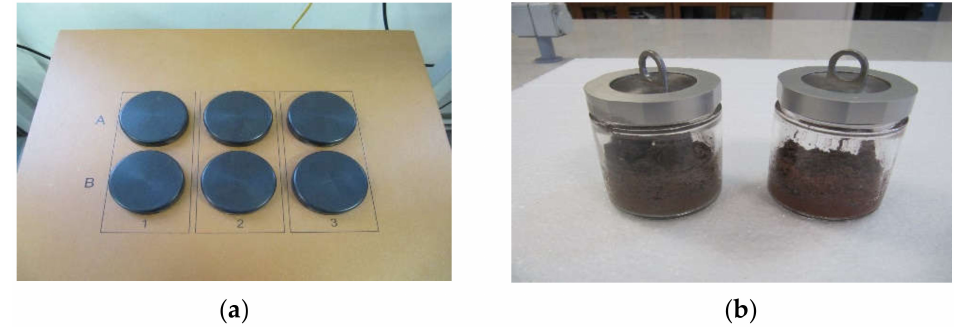
Figure 1. ( a ) Profiles of 3-channel TAM Air; ( b ) mortar specimens in a glass